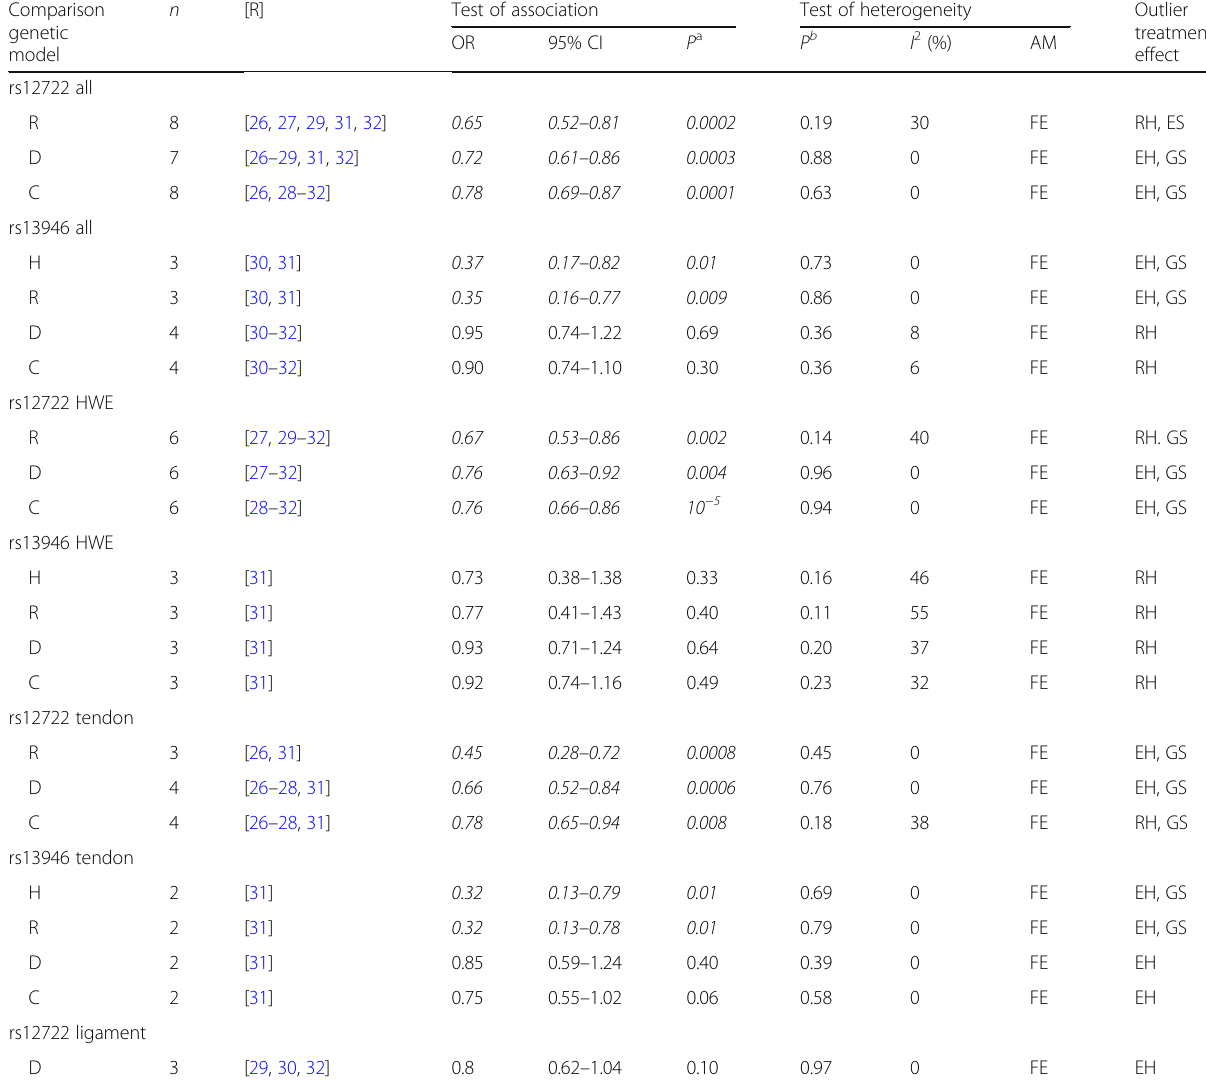
Table 3 Post-outlier analysis outcomes of the COL5A1 polymorphism associations with TLI Comparison genetic